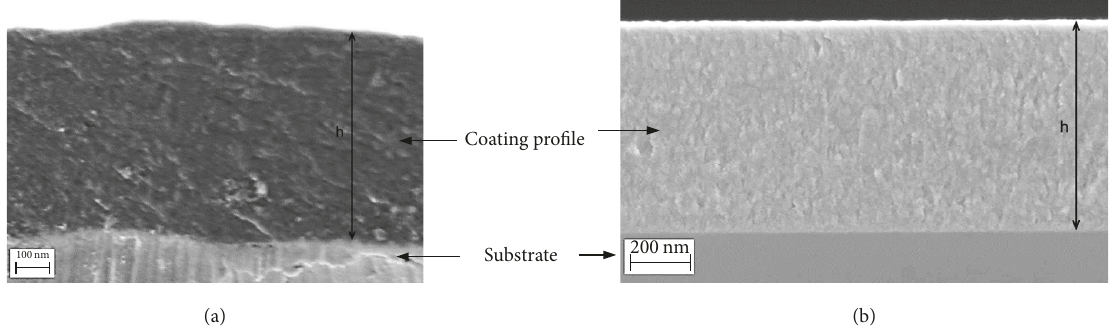
Figure 8: Cross-sectional SEM images of AlTiN coatings deposited at 200 Hz on 100Cr6-steel substrate (a) and silicon substrate (b) with film thickness ℎ = 0.729 𝜇 m.